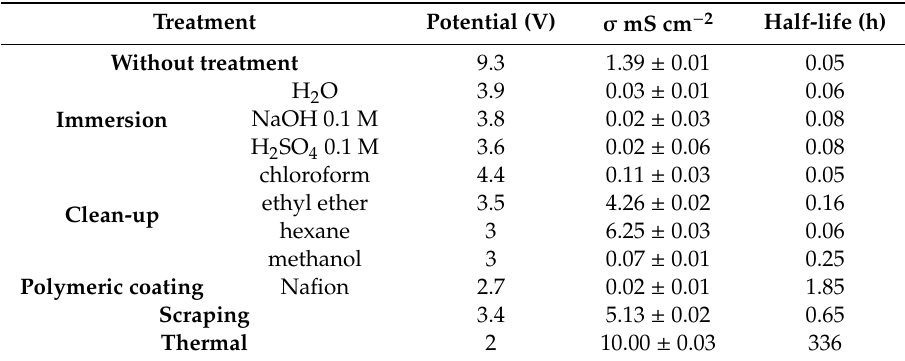
Table 1. Activation treatments of the